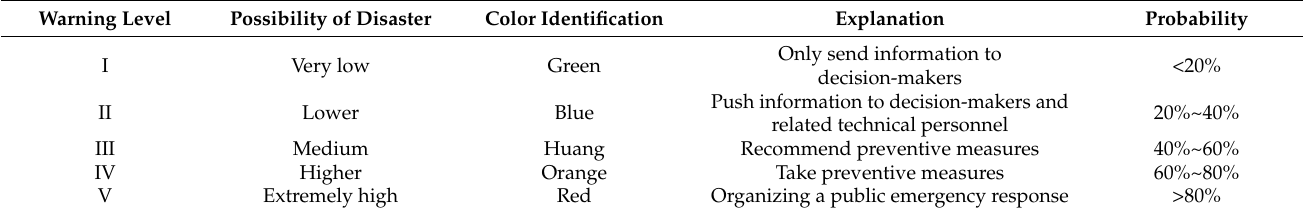
Table 7. Early warning classification of debris flow geological